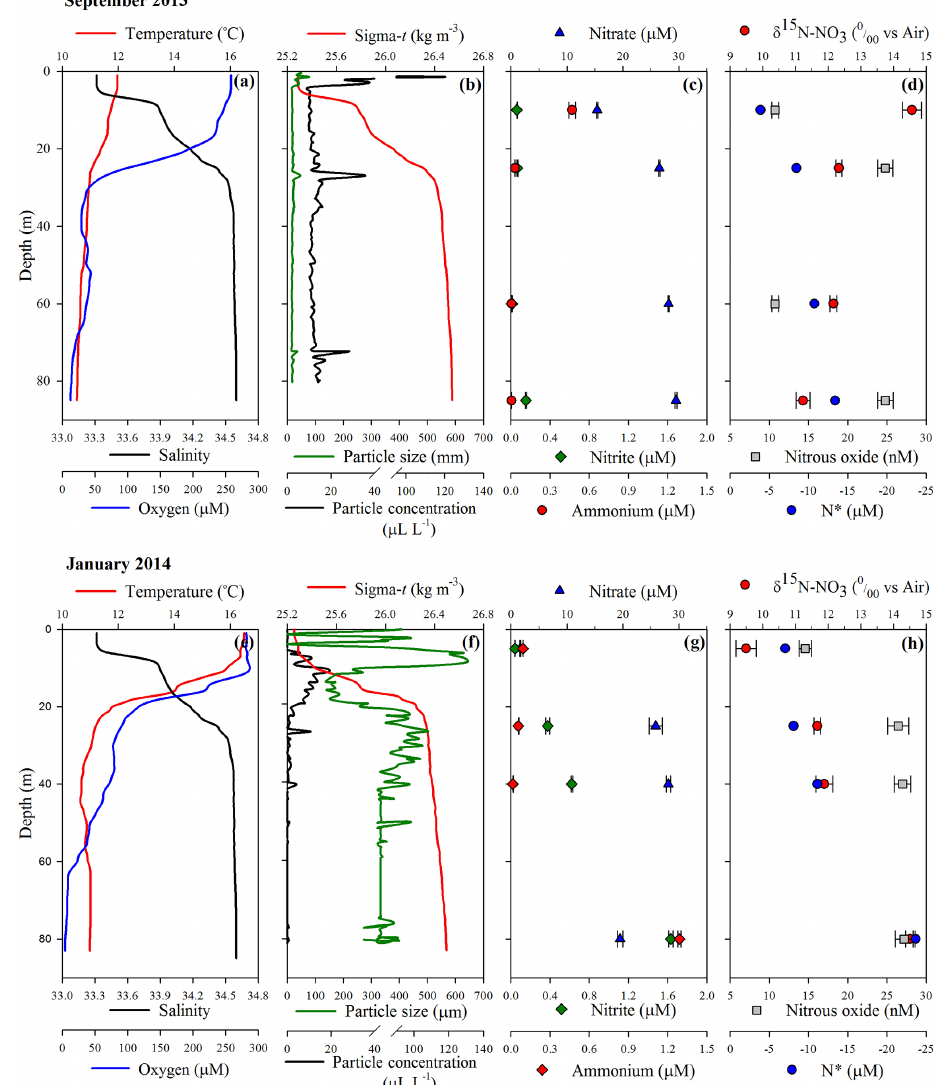
Figure 2. Water column profiles of hydrographic parameters during sampling periods ( a–d , 12 September 2013 and e–h , 28 January 2014) at station 18 over the continental shelf off central